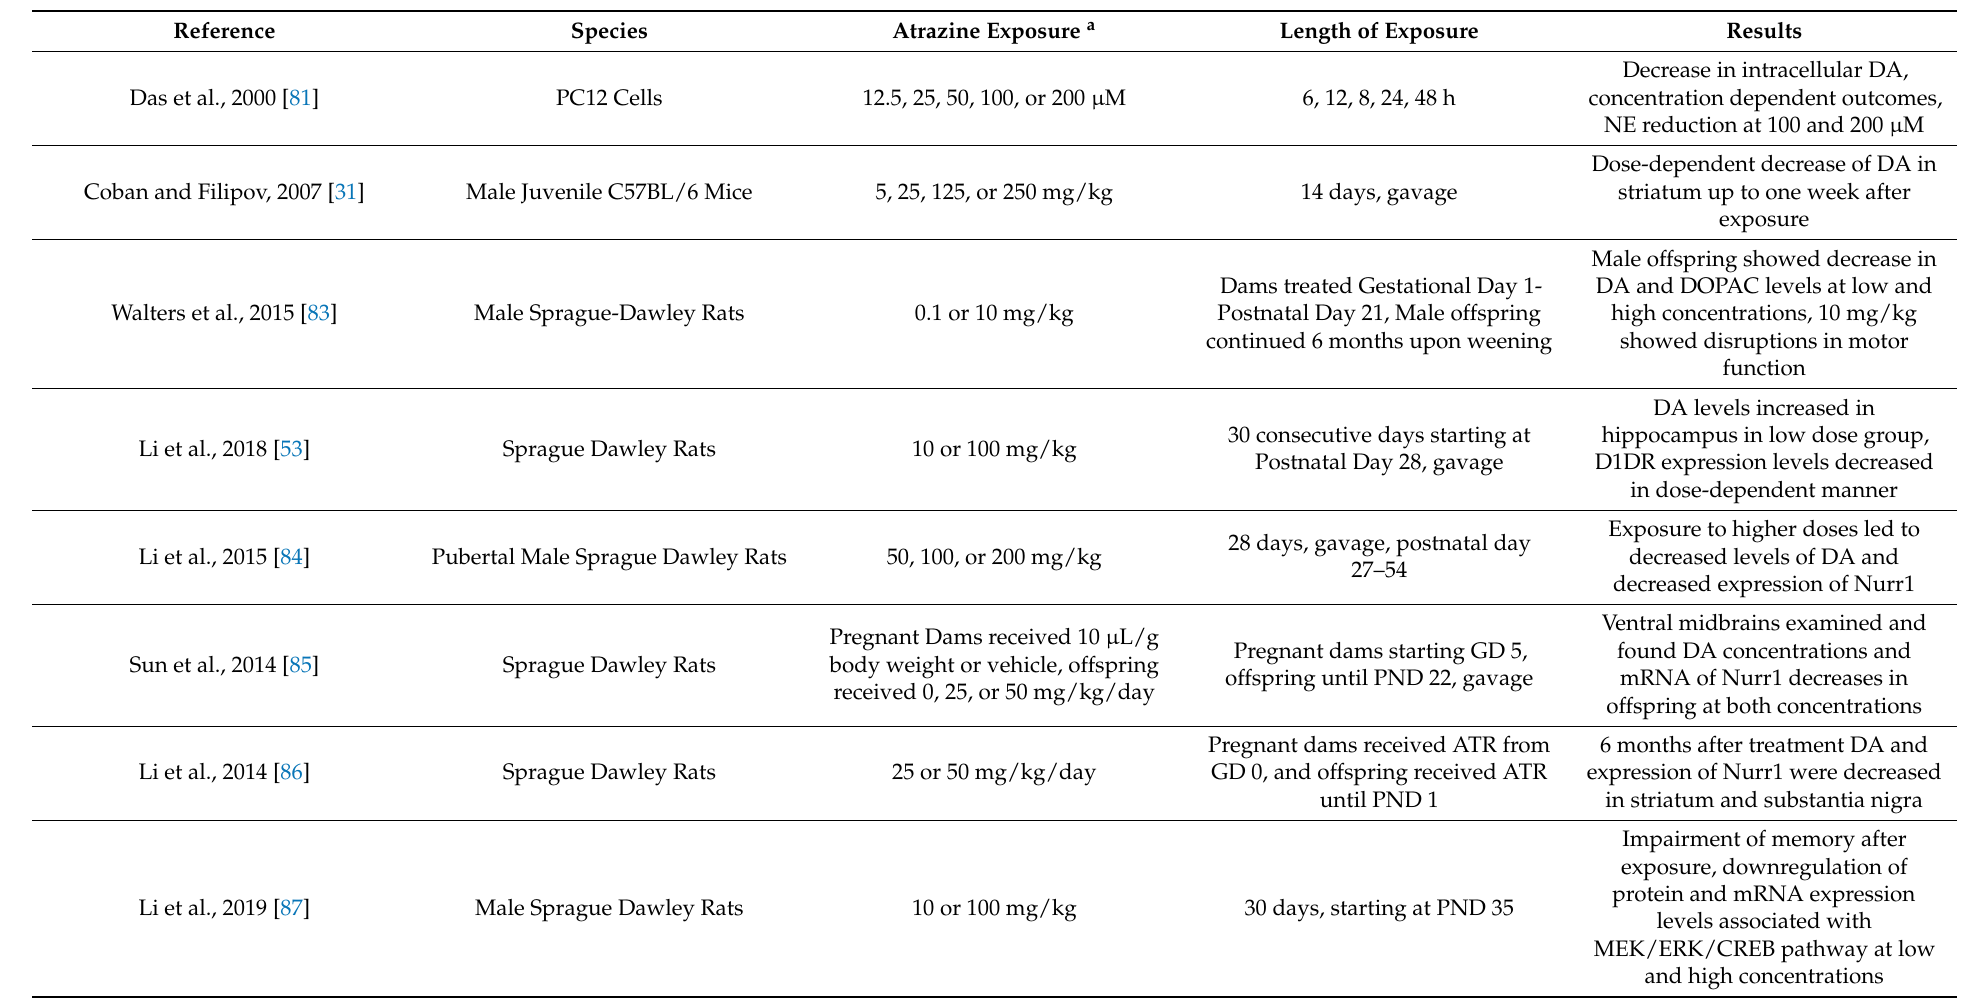
Table 2. Reported adverse effects on dopaminergic systems following atrazine